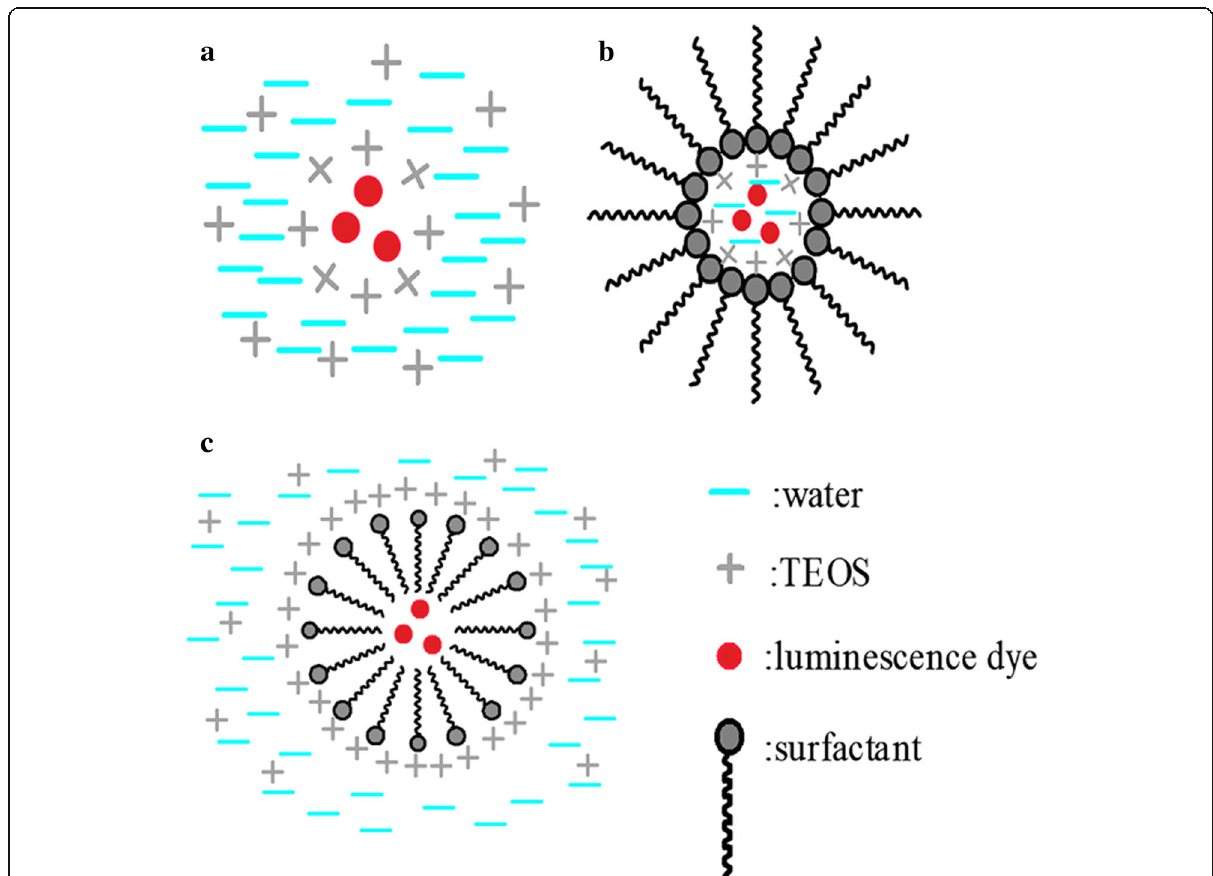
Fig. 11 The shematic illustrations of different LSNs with different methods. a For Stöber method. b For reverse microemulsion method, c For direct micelles assistant